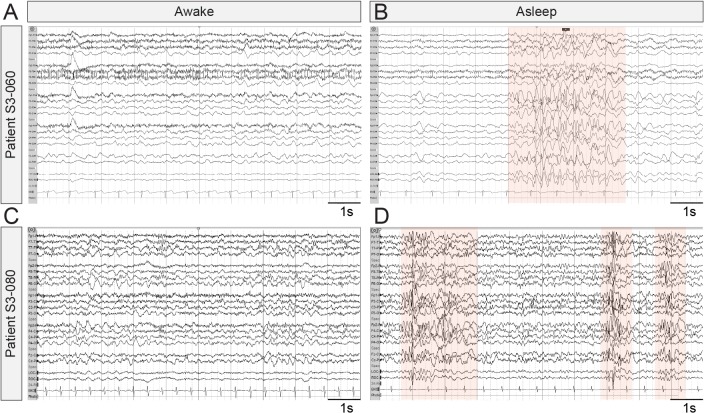
Representative EEG recordings taken from SYNGAP1 patients during wake and sleep.Ten second epochs of electroencephalograms from patients with SYNGAP1 pathogenic variants. (A) Patient S3-060 while awake (B) Patient S3-060 while asleep (C) Patient S3-080 while awake (D) Patient S3-080 while asleep. Shaded areas indicate bursts of generalized epileptiform activity.